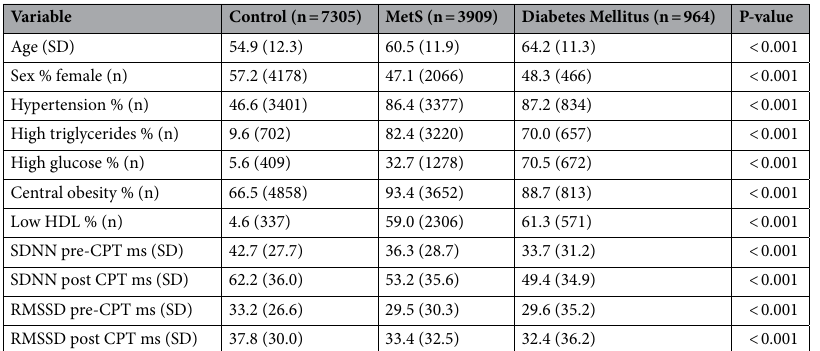
Table 1. Mean and standard deviation (continuous variables) or the percentage and number of participants (categorical variables) of select population characteristics in the control, MetS and DM subgroups. P-values from ANOVA (continuous variables) or chi-square tests (categorical